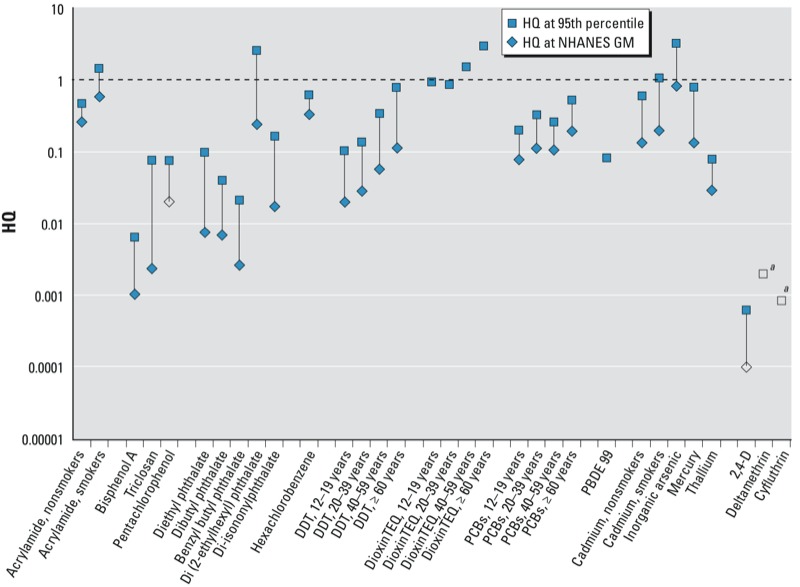
HQs for NER analytes with available BEs or other biomarker-based screening values, excluding VOCs (see Figure 2 for VOCs); screening values and NHANES data reported in Table 1. Open symbols correspond to the HQ at the limit of detection (LOD) in cases where the analyte was not detected in the NHANES survey at the specified quantile. For dioxin toxic equvalency (TEQ) and PBDE-99, concentrations were not quantifiable at the GM, and variable LODs in the NHANES data set prevent selection of a single value to represent LOD. DDT, dioxin TEQ, and PCBs HQs are shown by age in years. aDeltamethrin and cyfluthrin were not detected at either the GM or the 95th percentile; the HQ associated with the LOD is indicated in the figure.